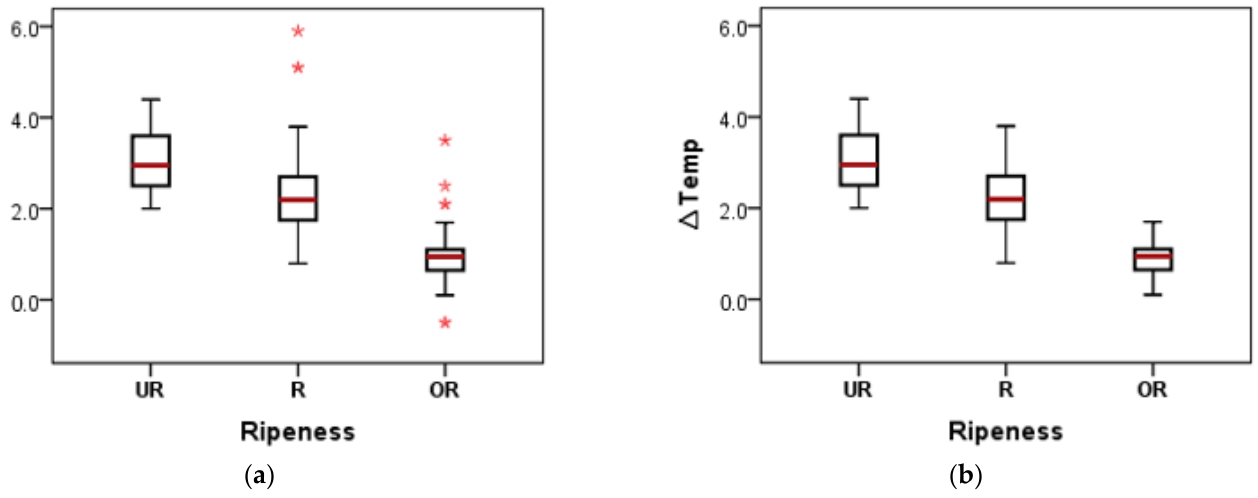
Figure 8. Box and whisker plots represent the ∆Temp of under -ripe, ripe, and over-ripe oil palm FFBs. ( a ) samples with outliers, ( b ) clean data, *: outlier samples. FFBs. ( a ) samples with outliers, ( b ) clean data, *: outlier samples.